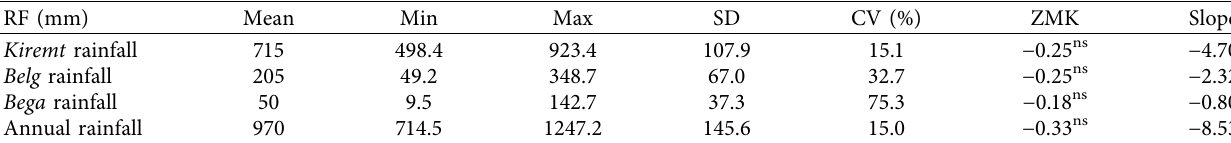
Table 3: Trends and descriptive statistics of annual and seasonal rainfall totals of Welmera district in the period of 1988–2017. RF (mm)